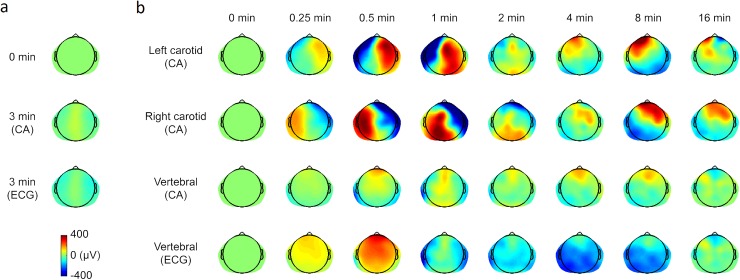
Spatiotemporal analysis of the DC-EEG data illustrated using heat maps.(a) Thiopental given at time 0 min generates a weak response in 3 min with slightly positive values along the midline and negative values at lateral electrode locations. Re-referencing the common average (CA) referenced data to the ECG reference renders the entire response slightly more negative. Data from all recordings (47 infusions) were pooled because thiopental was applied intravenously. (b) Temporal evolvement of the spatial distribution of DC-EEG responses to mannitol infusion shown using logarithmically increasing time intervals. The signal level preceding mannitol infusion (0 min) defines the zero level for the average responses calculated for 13 left carotid artery, 16 right carotid artery and 18 vertebral artery infusions. All data are shown using the CA reference montage. In addition, the bottom row of heat plots shows vertebral artery infusion data after re-referencing to the ECG reference.